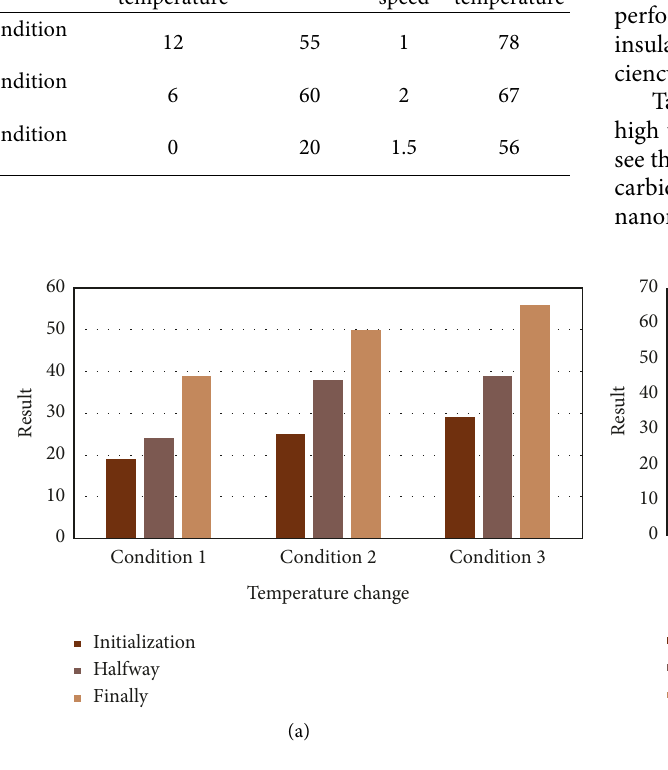
Figure 6: Temperature change of heat pump. Table 3: Pump value temperature of different coating materials.